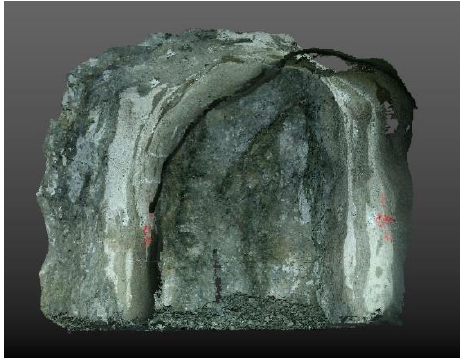
Figure 3. Typical drift environment point cloud data by SLAM.